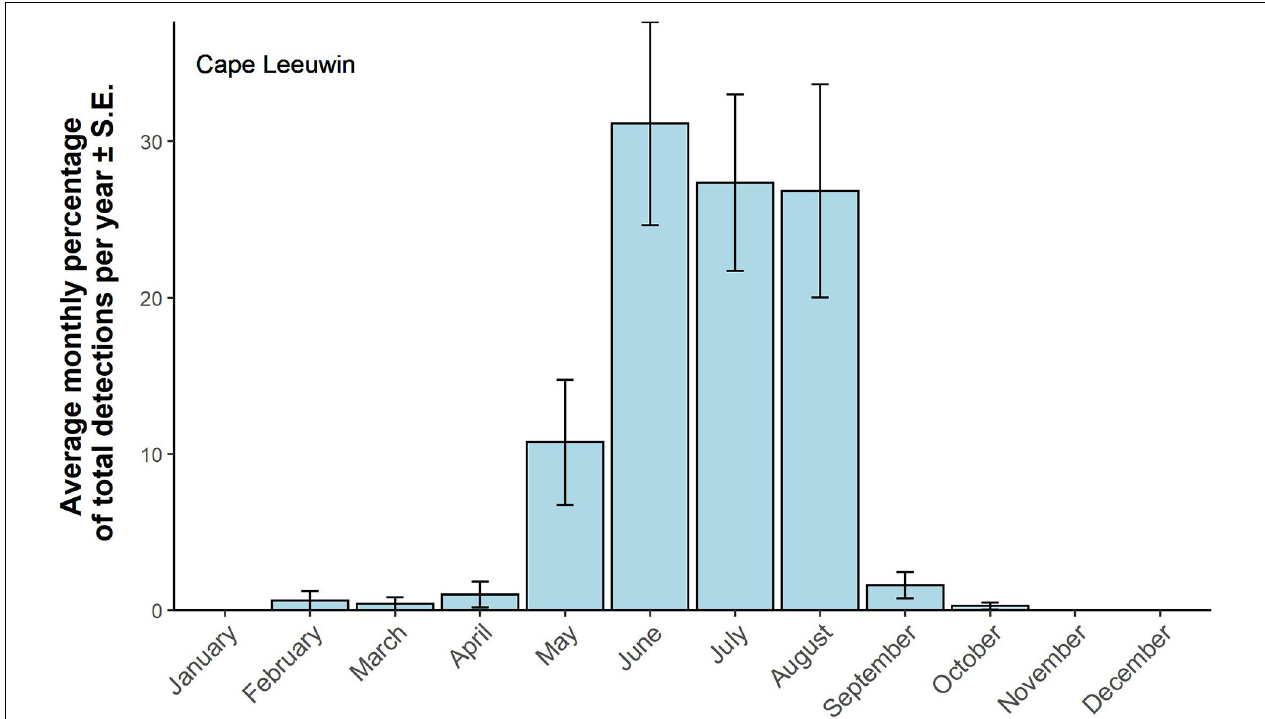
FIGURE 8 | Antarctic Blue whale detections at Cape Leeuwin. Averaged monthly detections ± SE. Monthly detections have been standardized by calculating the monthly percentage of total detections per year. Monthly detections were averaged over 16 years of available data.